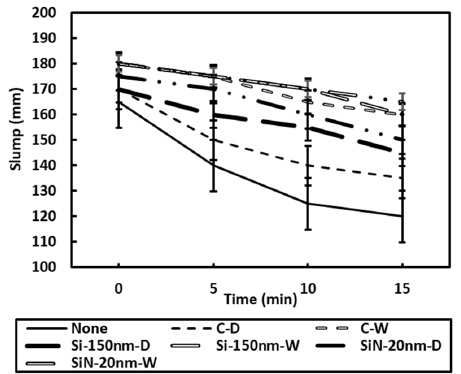
Figure 6. The slumps of concrete with different modified materials.